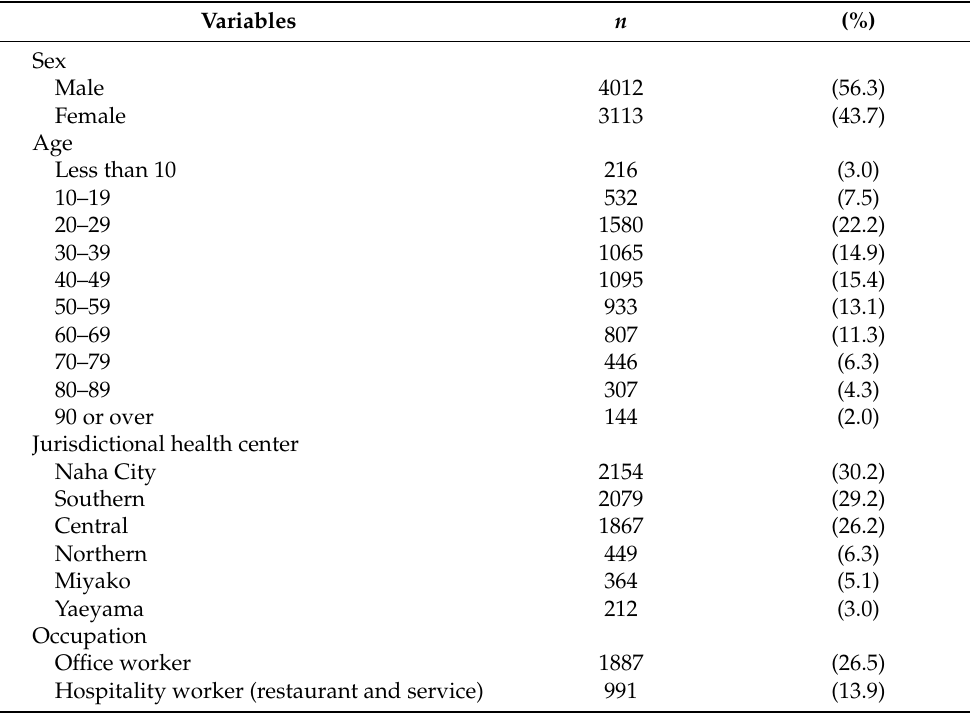
Table 1. Characteristics of persons with confirmed COVID-19 infection in Okinawa between